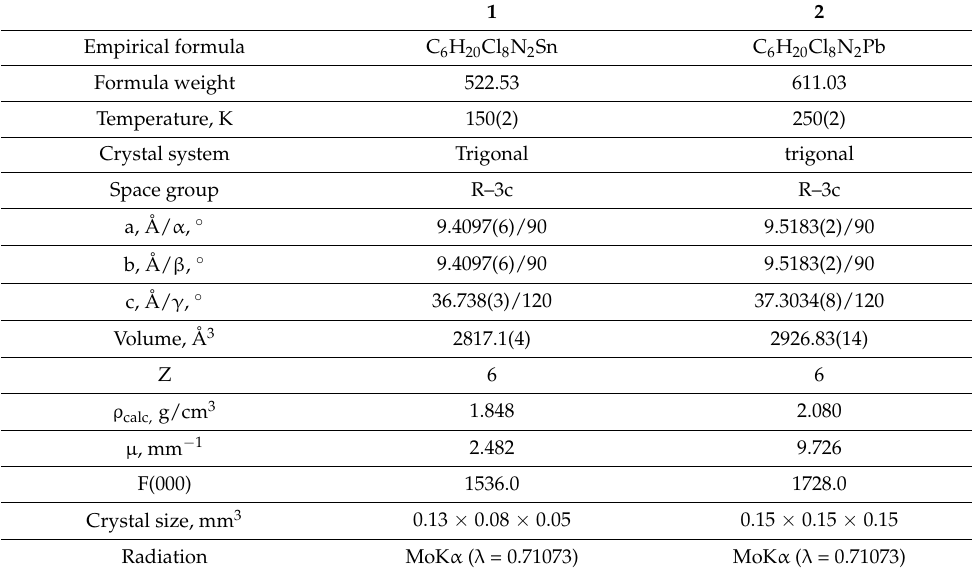
Table 1. Details of the XRD experiments for 1 and 2